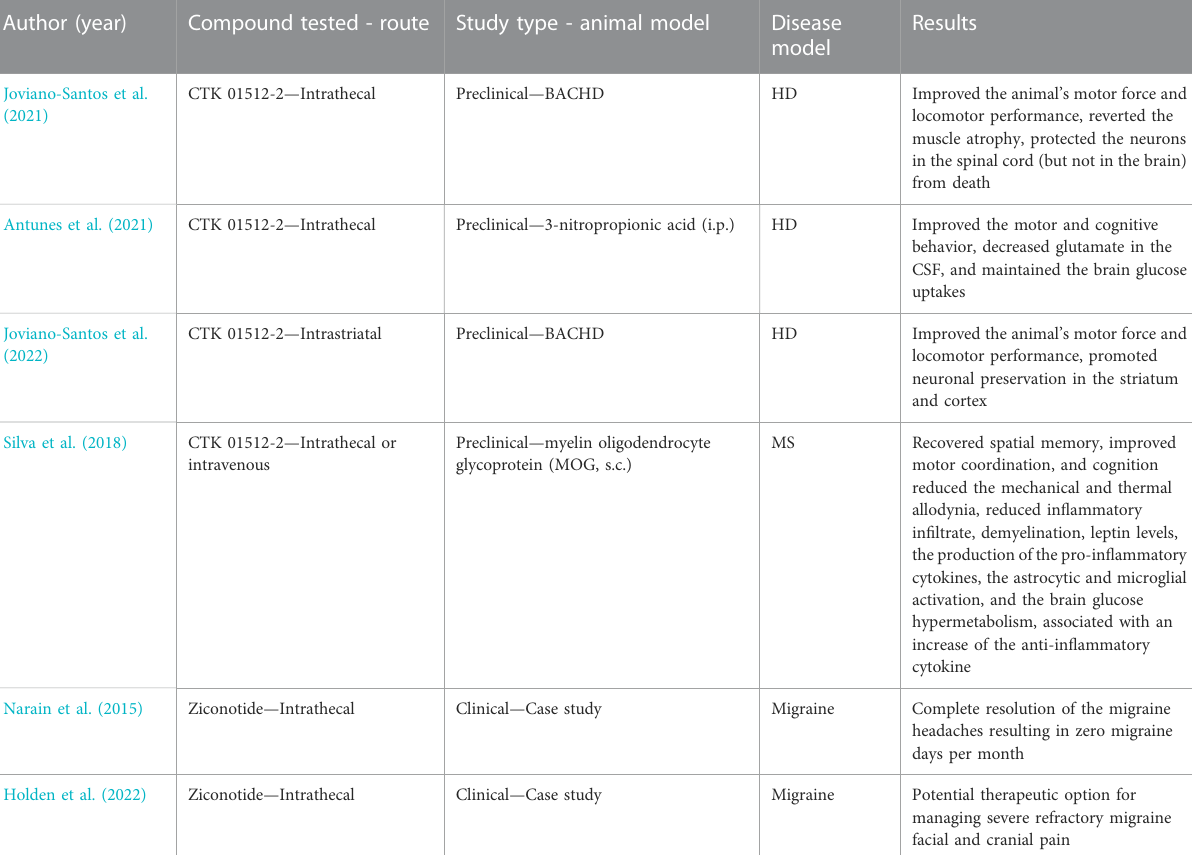
TABLE 2 Resume of studies about the NTCC blockers in Huntington ’ s disease (HD), Multiple Sclerosis (MS), and